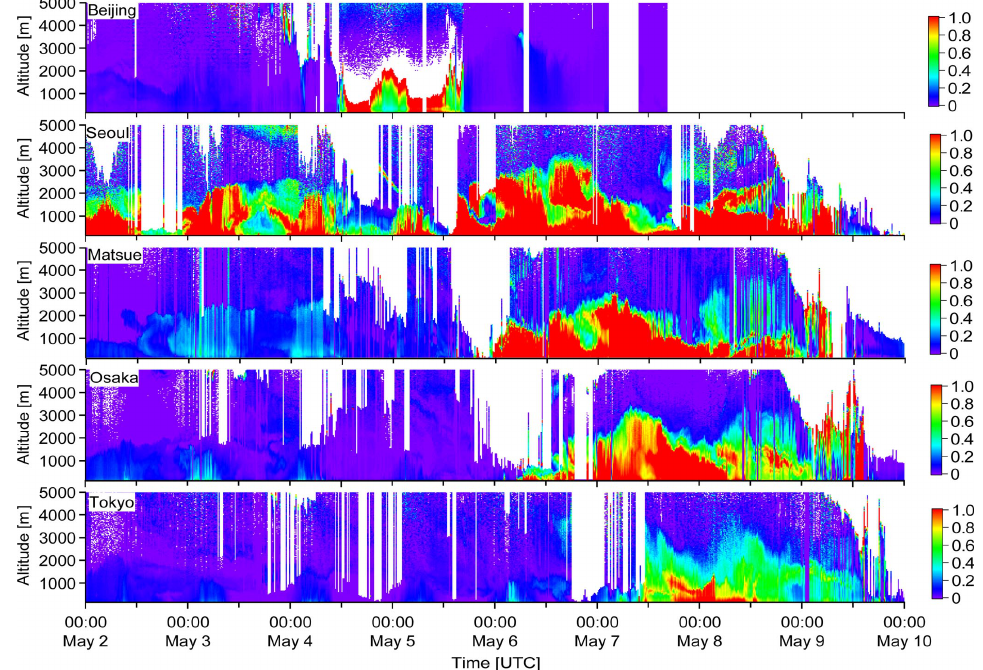
Figure 7. Lidar profile of dust vertical distribution in Beijing, Seoul, Matsue, Osaka, and Tokyo during 2–10 May 2017. Colours indicate depolarization ratio observed in ground